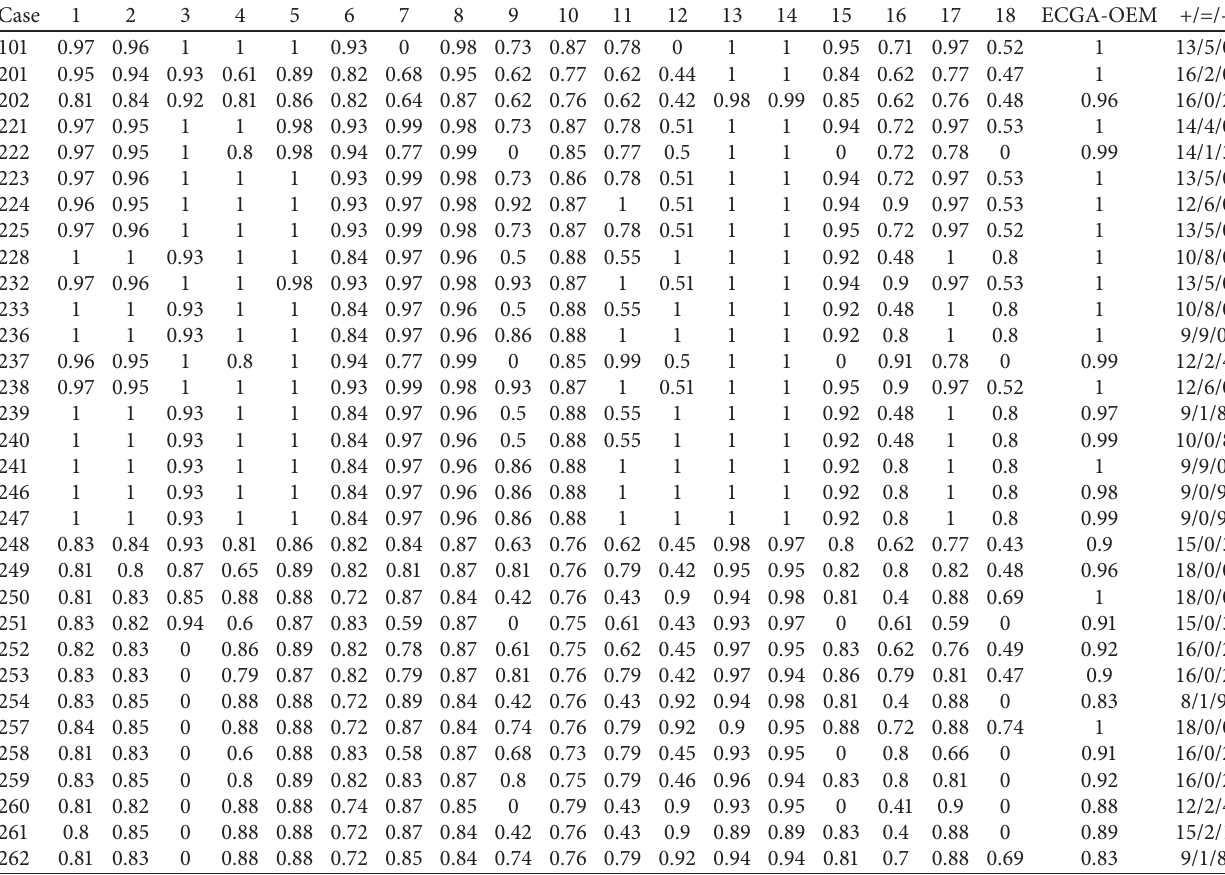
Table 4: Comparison on F -measure harmonic mean on each testing case among OAEI participants and ECGA-OEM.